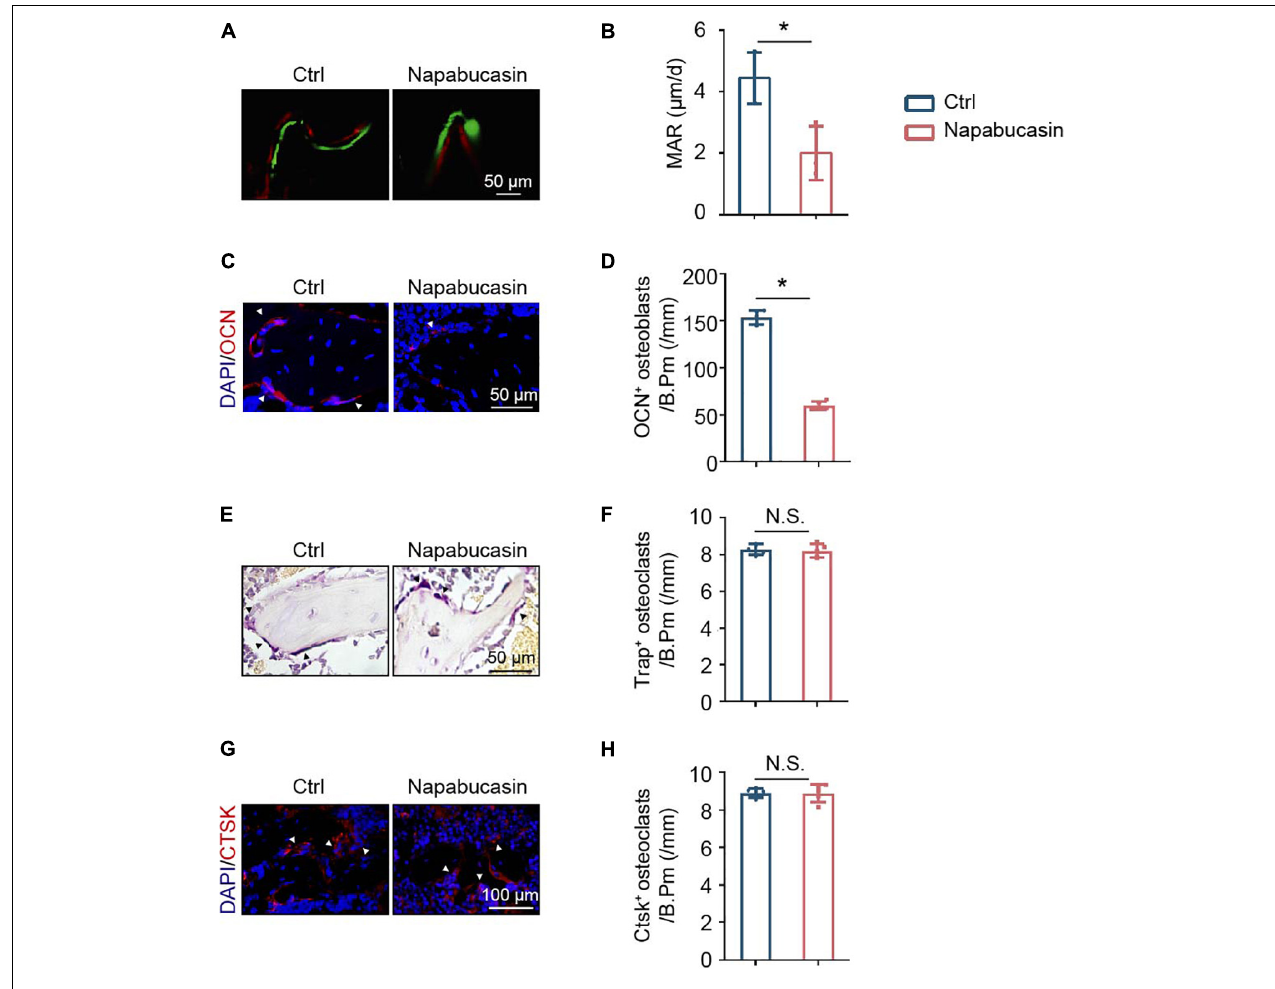
FIGURE 5 | Napabucasin impaired bone formation but did not change bone resorption. (A) Osteogenic activity in femora of mice determined by calcein and Alizarin Red double staining. (B) Mineral apposition rate (MAR) detected by histomorphometric analysis. N = 3. (C) Representative immunofluorescence image of OCN staining in femurs from the above mice. (D) Number of OCN + cells were counted. N = 5. (E) TRAP staining of femora from the above mice. (F) Number of TRAP + multi-nucleated osteoclasts were counted. N = 5. (G) Representative immunofluorescence image of CTSK staining in the femurs from the above mice. (H) Number of CTSK + cells were counted. N = 5. Data are represented as means ± S.D. * P <